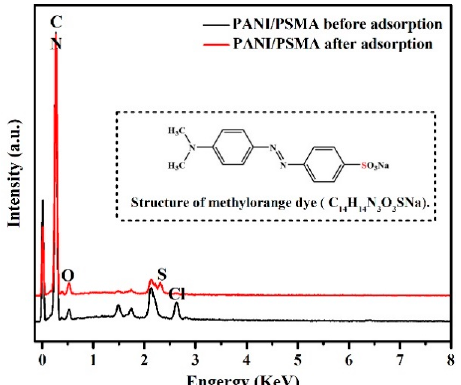
Figure 10. Energy-dispersive X-ray spectroscopy (EDS) spectra of the PANI/PSMA before and after adsorption (the inset in EDS spectra shows the structure of methyl orange dye).